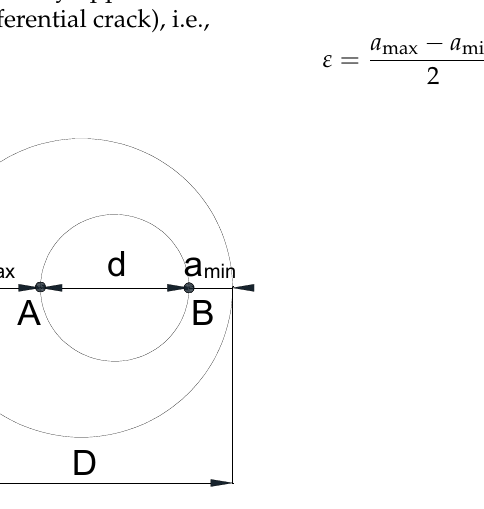
Figure 2. Details of the cracked area.